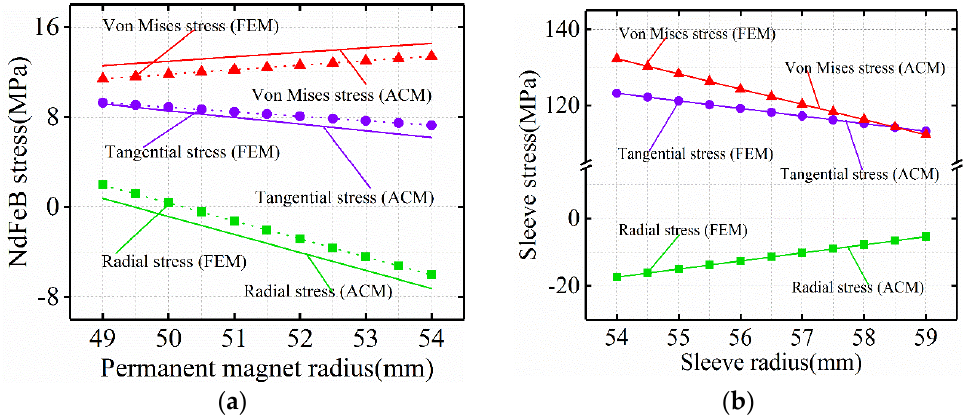
Figure 10. Stress distribution of ( a ) NdFeB-PM and ( b ) sleeve under cold rotating condition. Under the cold rotating condition, the radial stress of the FeCo-based PM presented as the compressive stress and the tangential stress as the tensile stress, and compared with that under the steady condition. The radial stress and the tangential stress of the FeCo-based PM all showed an increasing trend, that is, the compressive stress of the FeCo-based PM decreased, and after the rotation of the high-speed permanent magnetic rotor, the overfilling between the sleeve of titanium alloy and the FeCo-based PM decreased, which caused the contact pressure to decrease, leading to the reduction of the compressive stress of the FeCo-based PM. Corresponding to it, the NdFeB PM radial stress was similarly presented as compressive stress and the tangential stress as tensile stress.